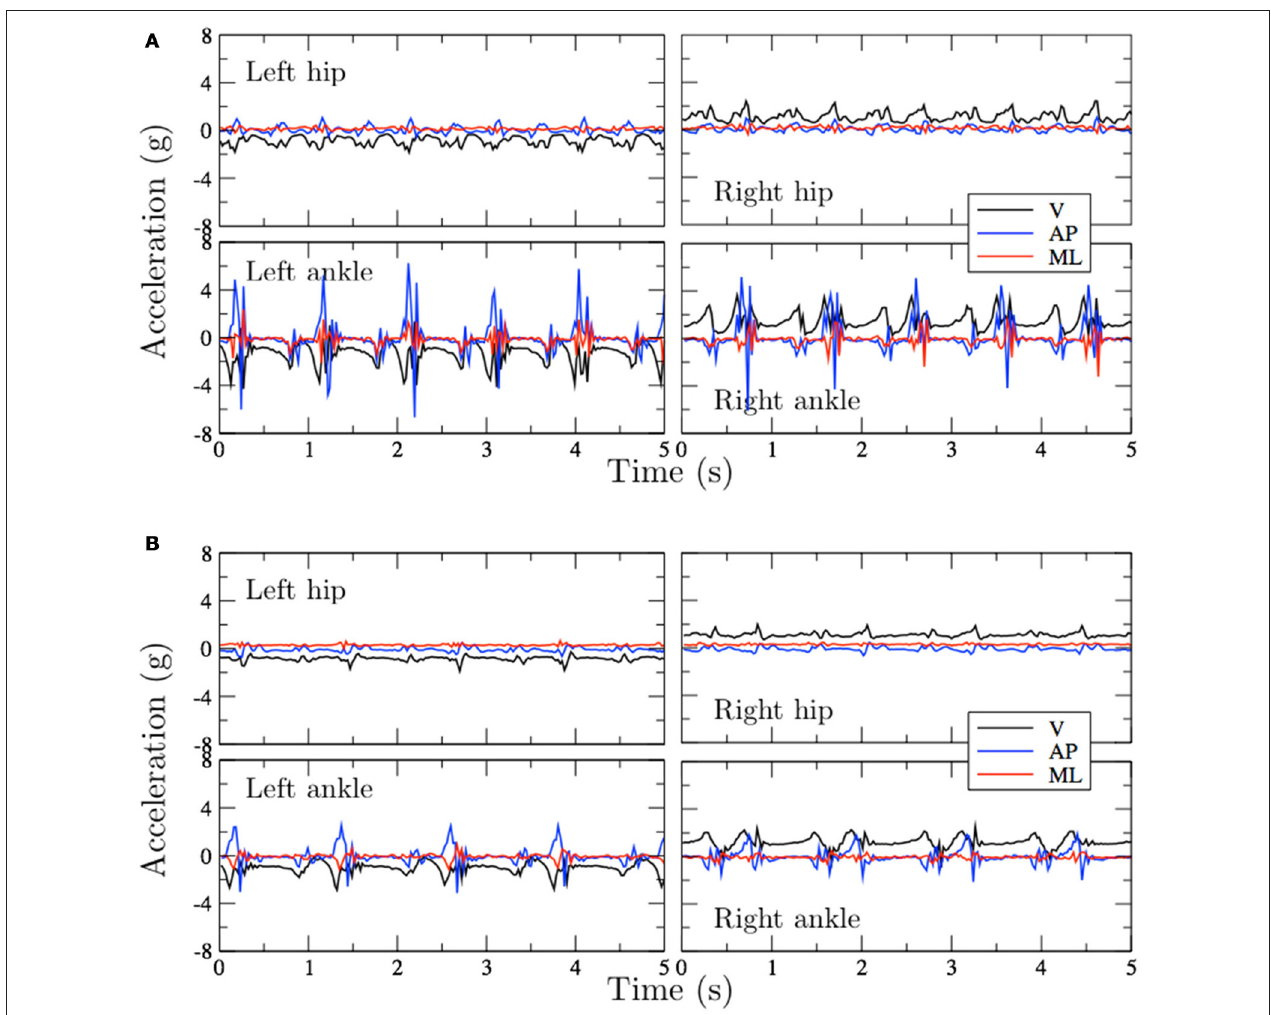
FIGURE 3 | Acceleration signals obtained from experiments with two subjects walking on an indoor corridor. (A) Control (65 years). (B) PAD patient (68